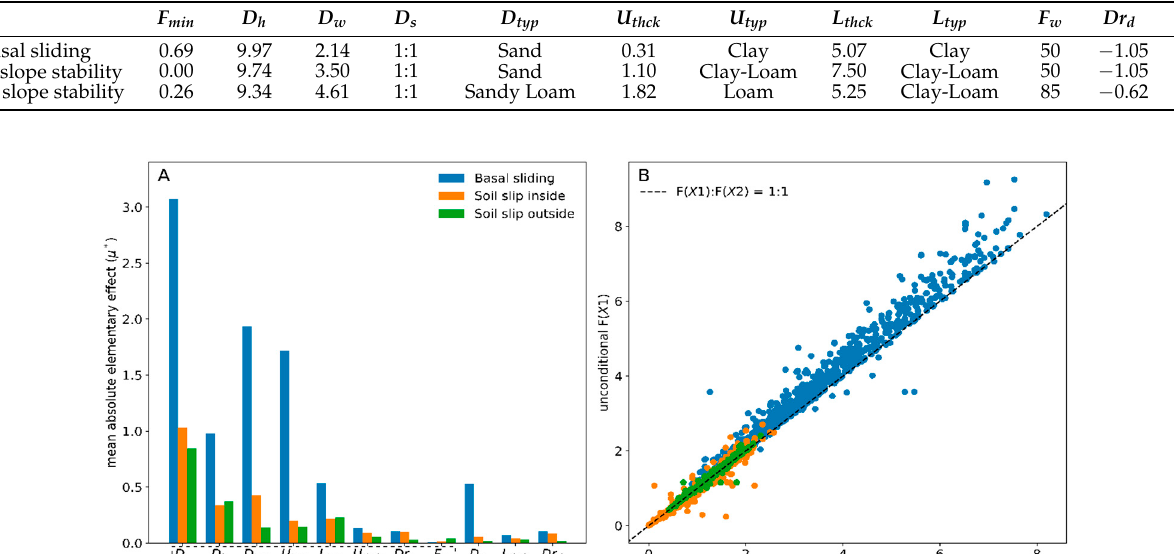
Figure 6. Factor Elementary Effects, leading to the factor rank per failure mechanism ( A ). Fixing the insensitive factors results in the final scatter plot between the results of the unconditional (unfixed) input, and conditional (partly fixed) input ( B ), leading to a combined r 2 of 0.985. Eight parameters (selection x-axis) are selected for the Monte-Carlo analysis, namely dike slope ( D s ), dike height ( D s ), dike material type ( D typ ), upper layer material type ( U typ ), lower layer material type ( L typ ), upper layer thickness ( U thck ), drainage spacing ( Dr s ) and foreland width ( F w